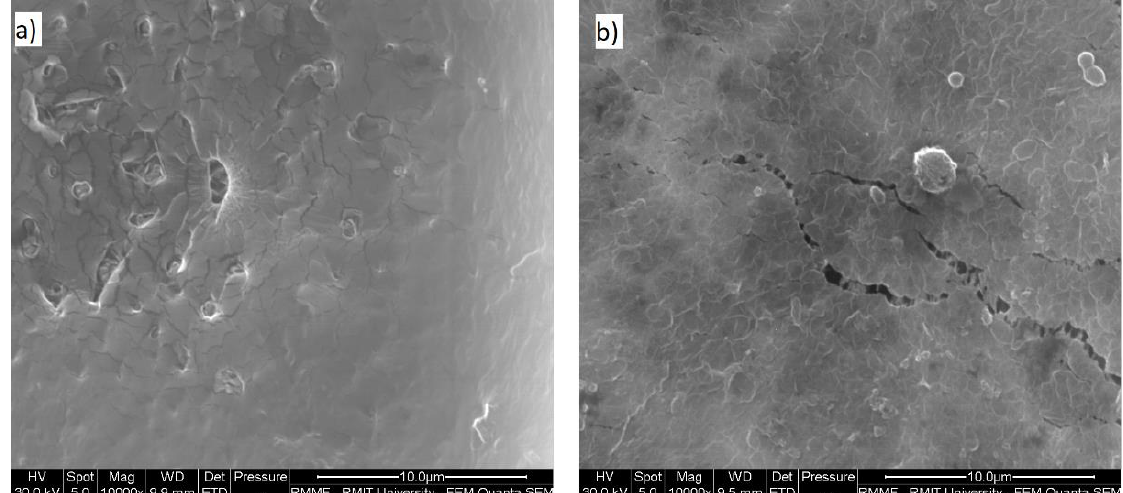
Figure 8. SEM images at 5000× of PVDF flat-sheet membrane used for the treatment of ( a ) TSWW and ( b ) GSWW. Table 7. EDS elemental composition of the new membrane in comparison with the membrane used to filter textile synthetic wastewater (TSWW).